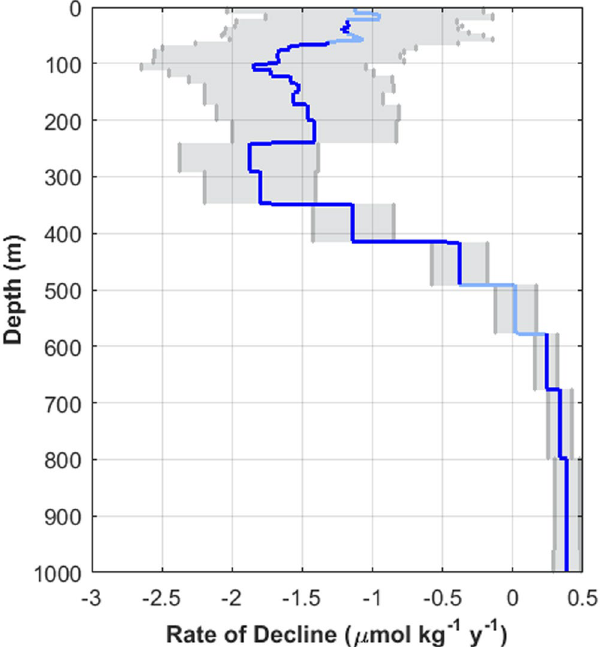
Figure 6. Depth profile of the rate of decline of dissolved oxygen concentration ( µ mol kg − 1 year − 1 ) on Line 67 (blue line). The 95% confidence level of the rate of decline is shaded in gray. Rates of change that are not significant (p > 0.01, Student’s t-test) are plotted in light blue.